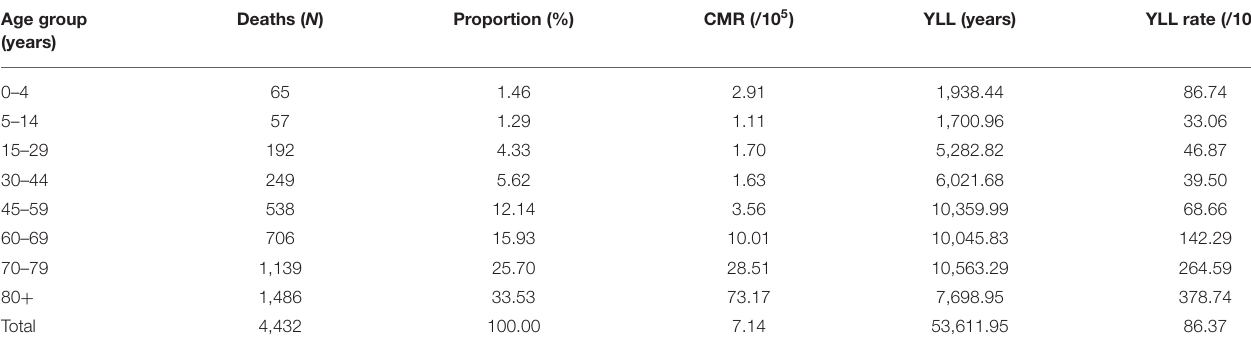
TABLE 2 | Age-specific mortality and burden of selected neurological disorders during